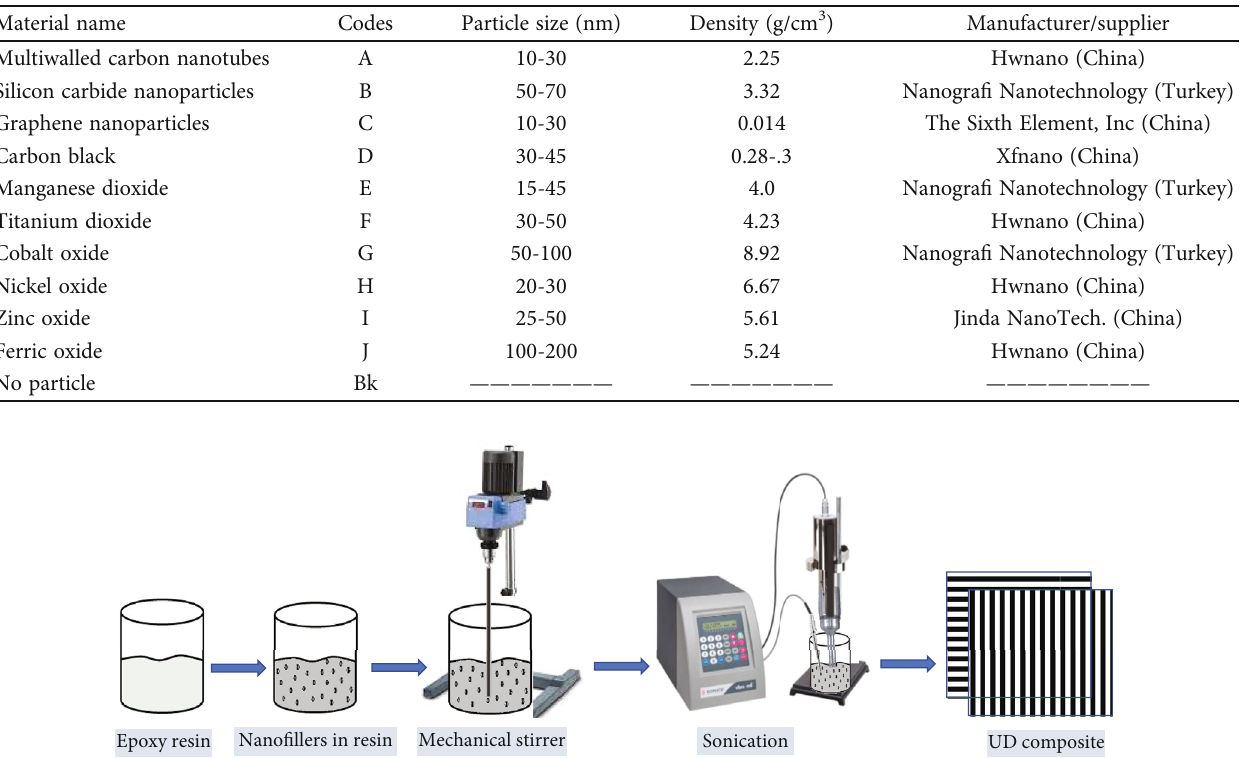
Table 2: Speci fi cations of di ff erent dielectric and magnetic materials.